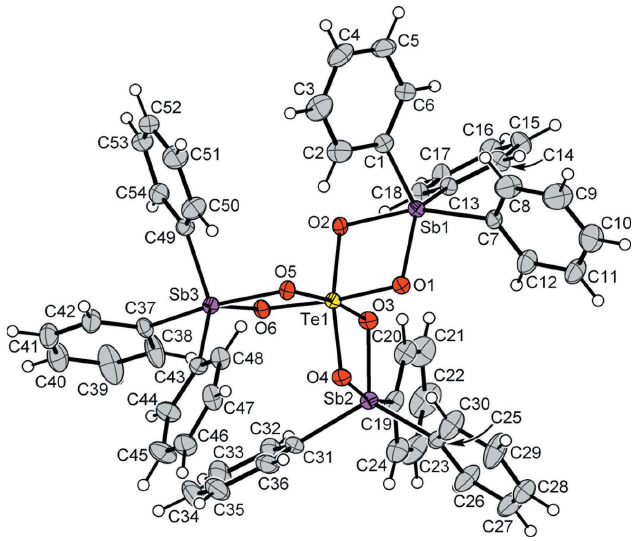
Figure 1 The molecular structure of the title compound with displacement ellipsoids drawn at the 40% probability level. Hydrogen atoms are represented by small circles of arbitrary radius.